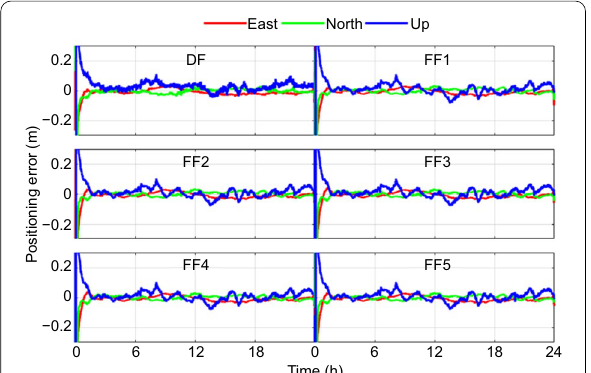
Fig. 14 Positioning error of simulated kinematic PPP solution among different PPP models on station met3 (DOY 283/2021)